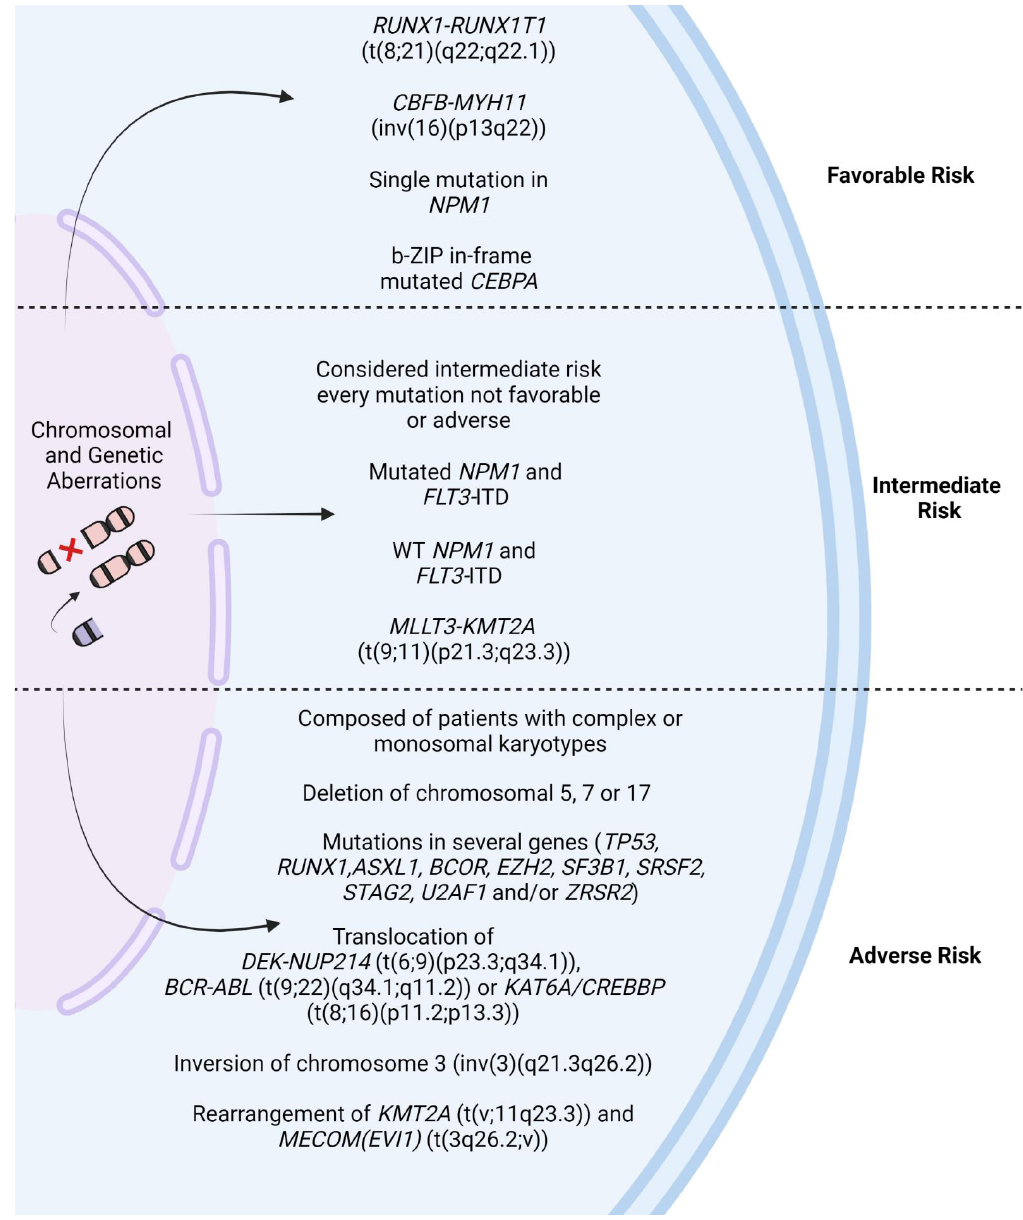
Figure 1. Cytogenetic and chromosomal abnormalities associated with prognostic risk groups in acute myeloid leukemia (AML). RUNX1: RUNX family transcription factor 1; RUNX1T1: RUNX1 partner transcriptional co-repressor 1; CBFB: core-binding factor subunit beta; MYH11: myosin heavy chain 11; CEBPA: CCAAT enhancer binding protein alpha; NPM1: nucleophosmin 1; bZIP: basic leucine zipper domain; FLT3-ITD: fms-related receptor tyrosine kinase 3—internal tandem duplication; WT: wild-type; KMT2A: lysine methyltransferase 2A; MLLT3: MLLT3 super elongation complex subunit; TP53: tumor protein p53; ASXL1: ASXL transcriptional regulator 1; BCOR: BCL6 corepressor; EZH2: enhancer of zeste 2 polycomb repressive complex 2 subunit; SF3B1: splicing factor 3b subunit 1; SRSF2: serine and arginine rich splicing factor 2; STAG2: stromal antigen 2; U2AF1: U2 small nuclear RNA auxiliary factor 1; ZRSR2: zinc finger CCCH-type, RNA-binding motif and serine/arginine rich 2; DEK: DEK proto-oncogene; NUP214: nucleoporin 214; BCR: BCR activator of RhoGEF and GTPase; ABL: ABL proto-oncogene 1; KAT6A: lysine acetyltransferase 6A; CREBBP: CREB binding protein; KMT2A: histone-lysine N-methyltransferase 2A; MECOM (EVI1): ecotropic virus integration site 1 protein homolog. Created with